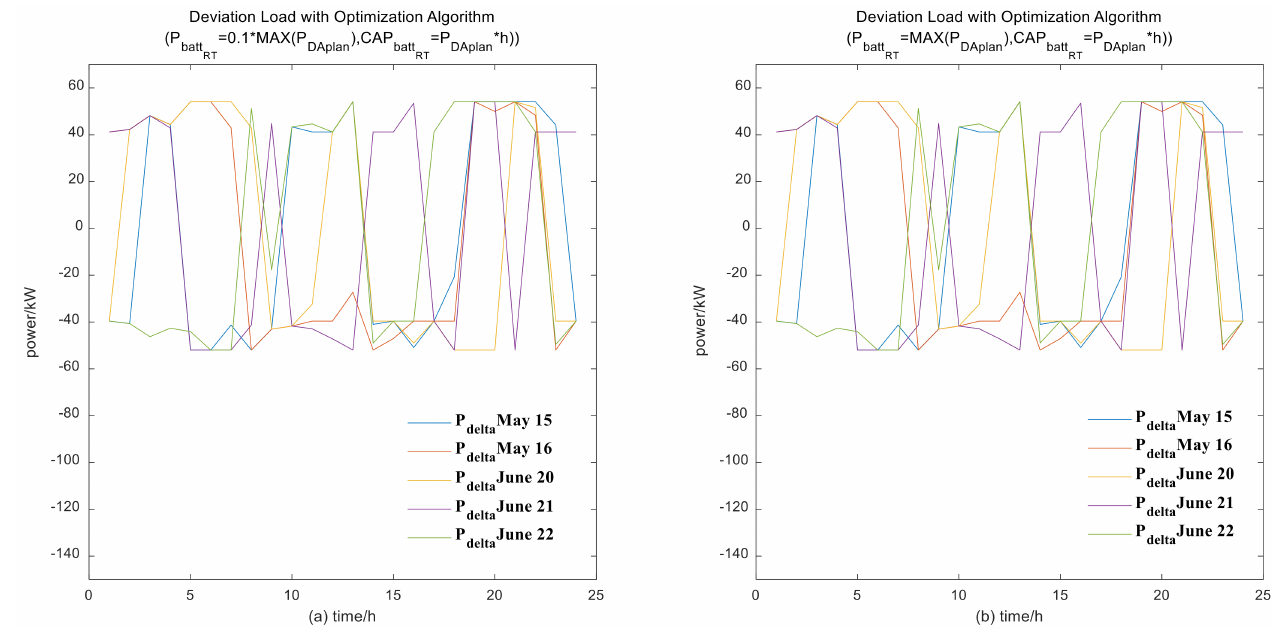
Figure 11. Deviation between real-time load and DA declared